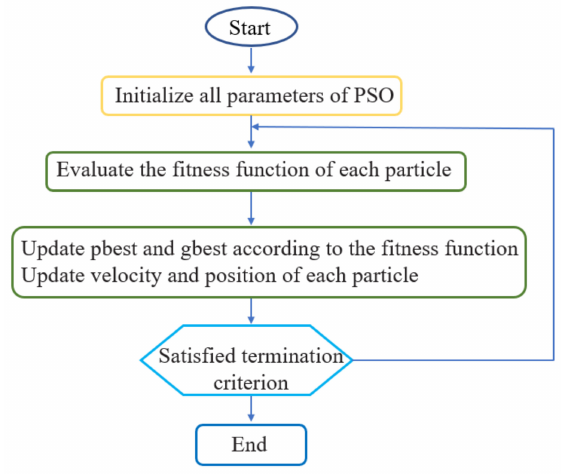
Figure 22. The PSO algorithm flowchart.